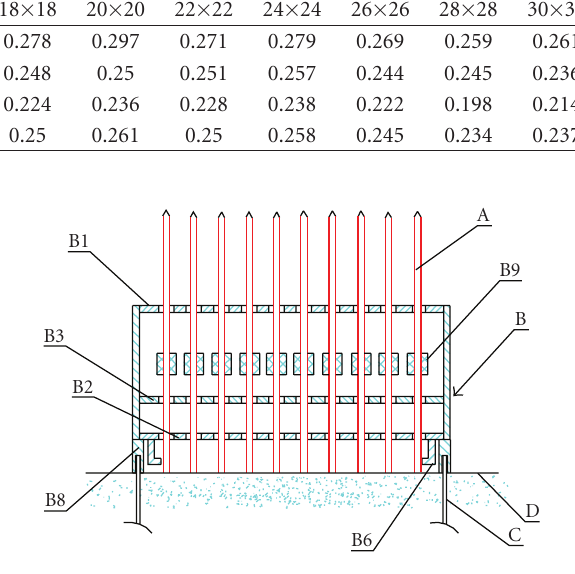
Figure 3: Schematic of the instrument Section